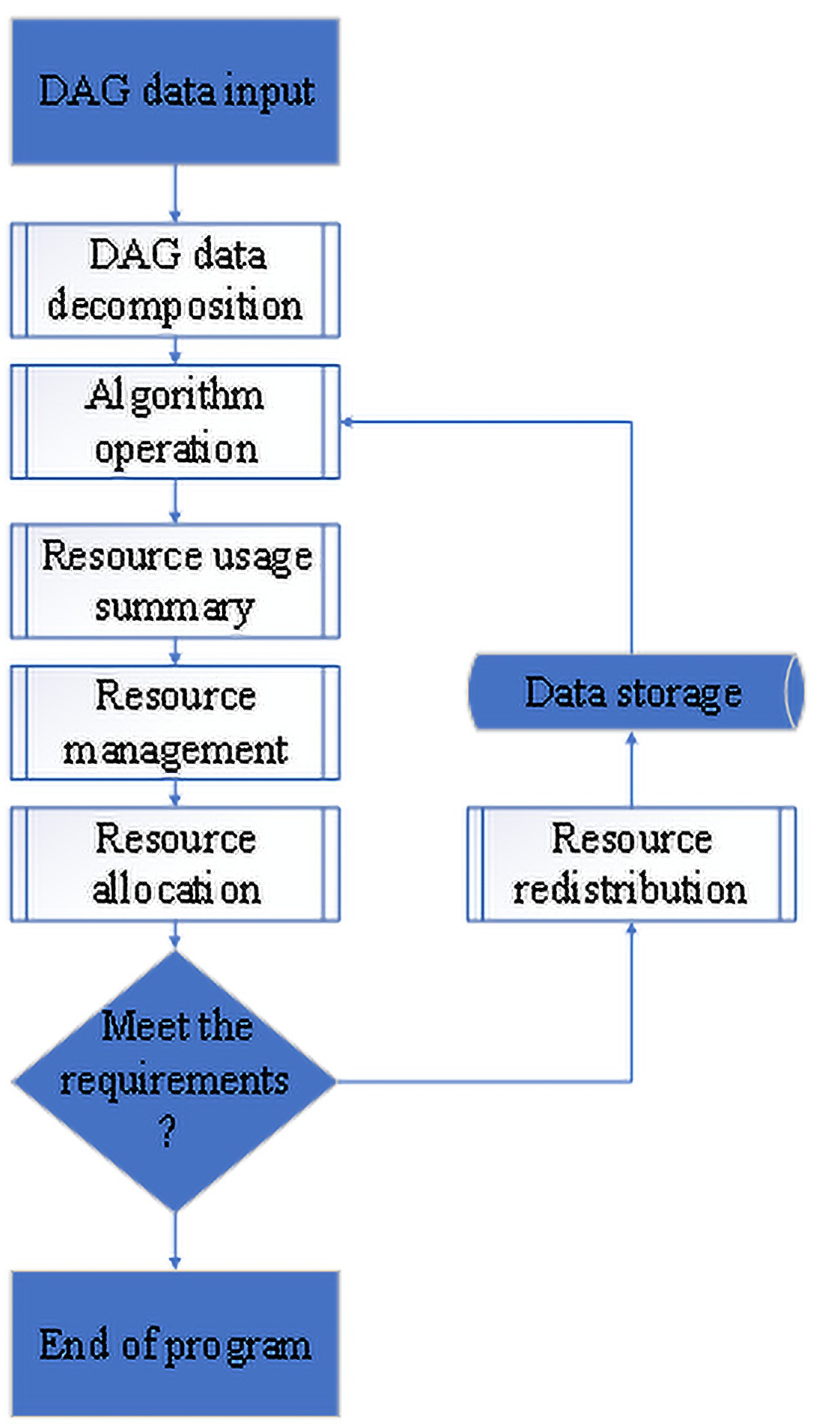
Fig 3. Overall flow of the NAG algorithm.